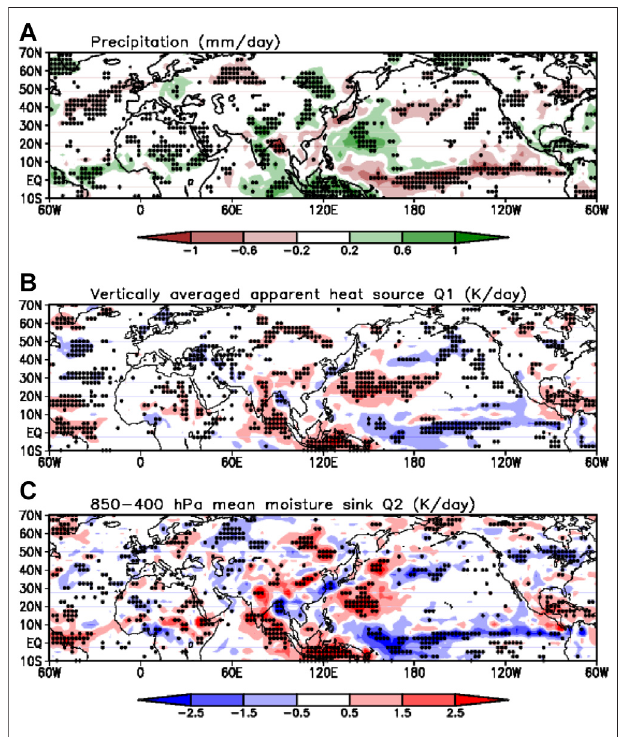
FIGURE 7 | Regression map of precipitation (GPCP), apparent heat source(Q1),andmoisturesink(Q2)inJulyagainstPCtimeseries.Dotsdenote signi fi cant area at the 95%